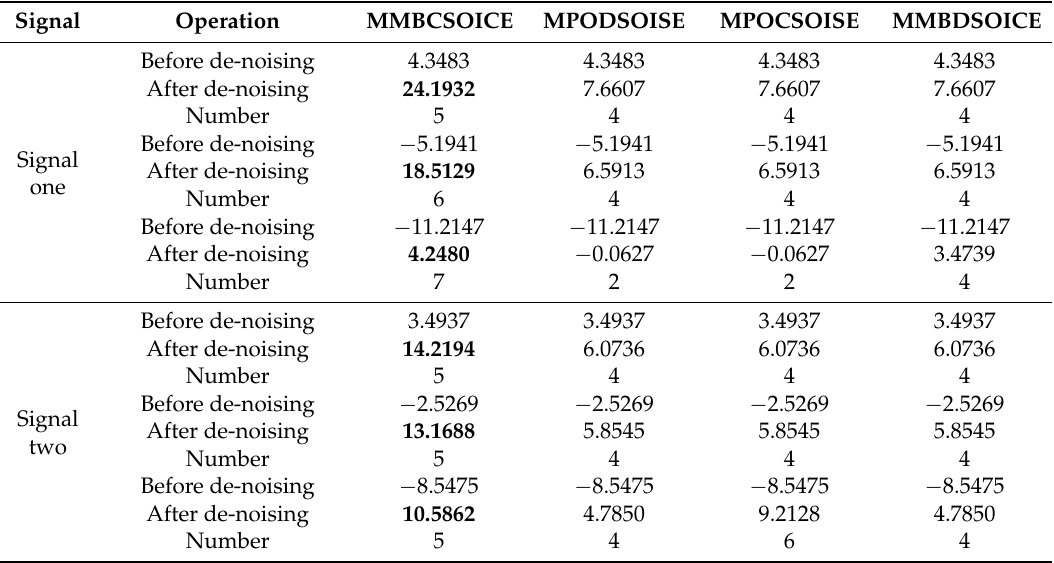
Table 1. Comparison of signal-to-noise ratio (SNR) and effective number of singular values about two de-noised signals.